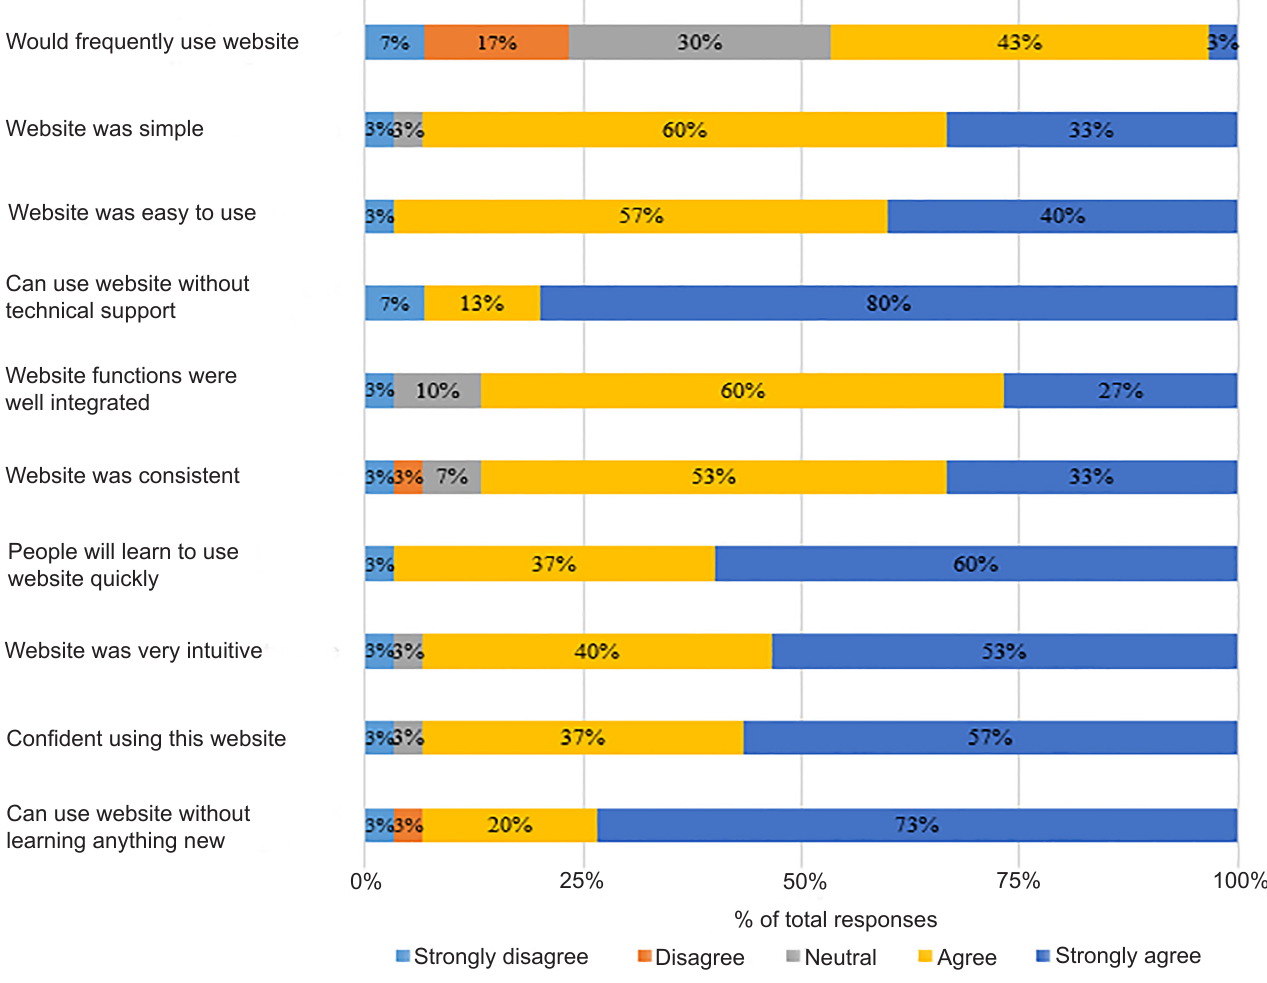
Strongly disagree